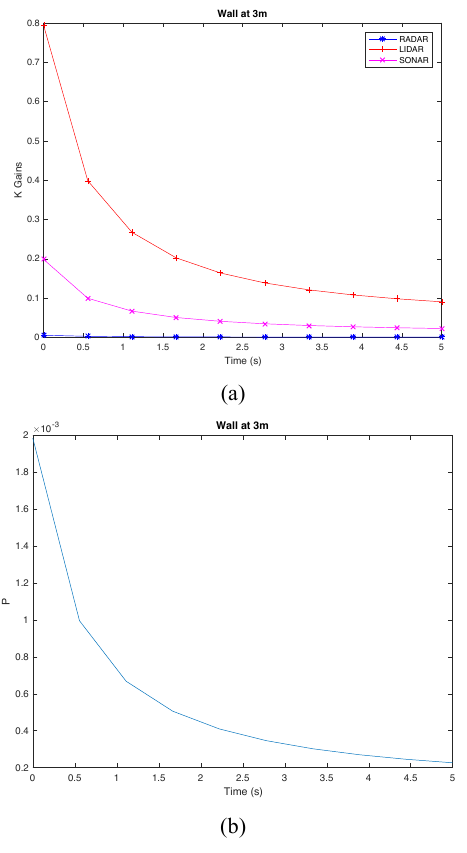
Figure 9 (a) K gains, (b) P error covariance